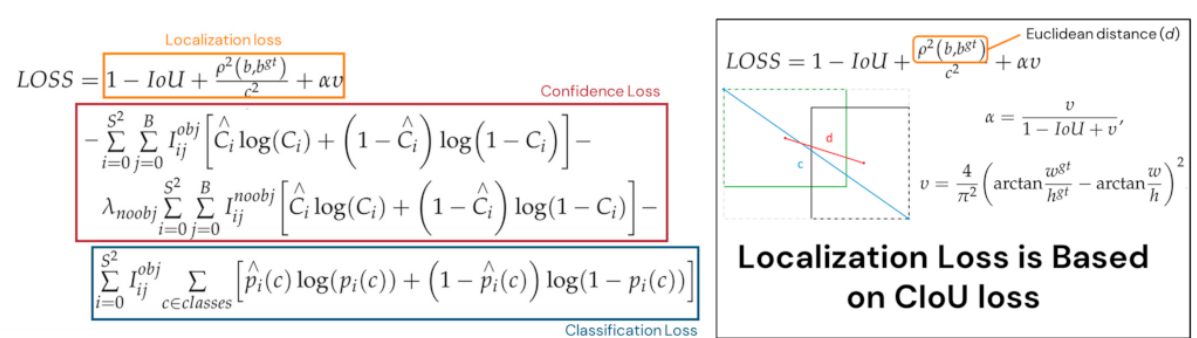
Figure 10. ( Left ) The complete YOLOv4 Loss Function; ( Right ) details of the localization loss based on Complete Intersection- over-Union loss.